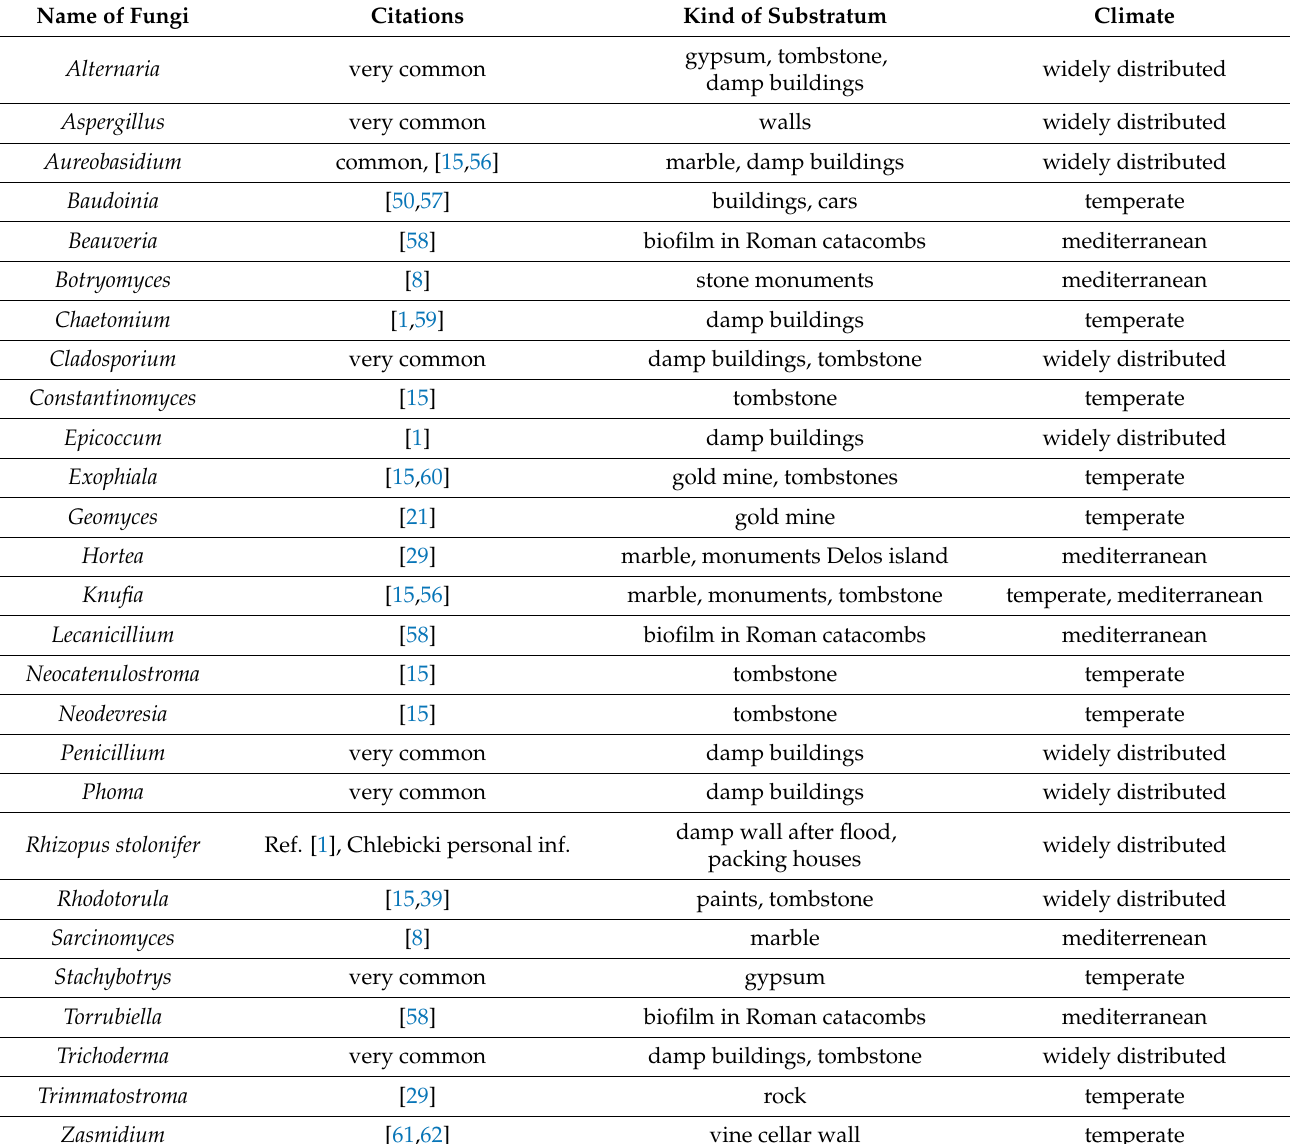
Table 2. The most frequent strains of fungi identified in diverse architectural buildings, with published references, focusing on the diverse climate of Earth. The most common fungal species are highlighted in